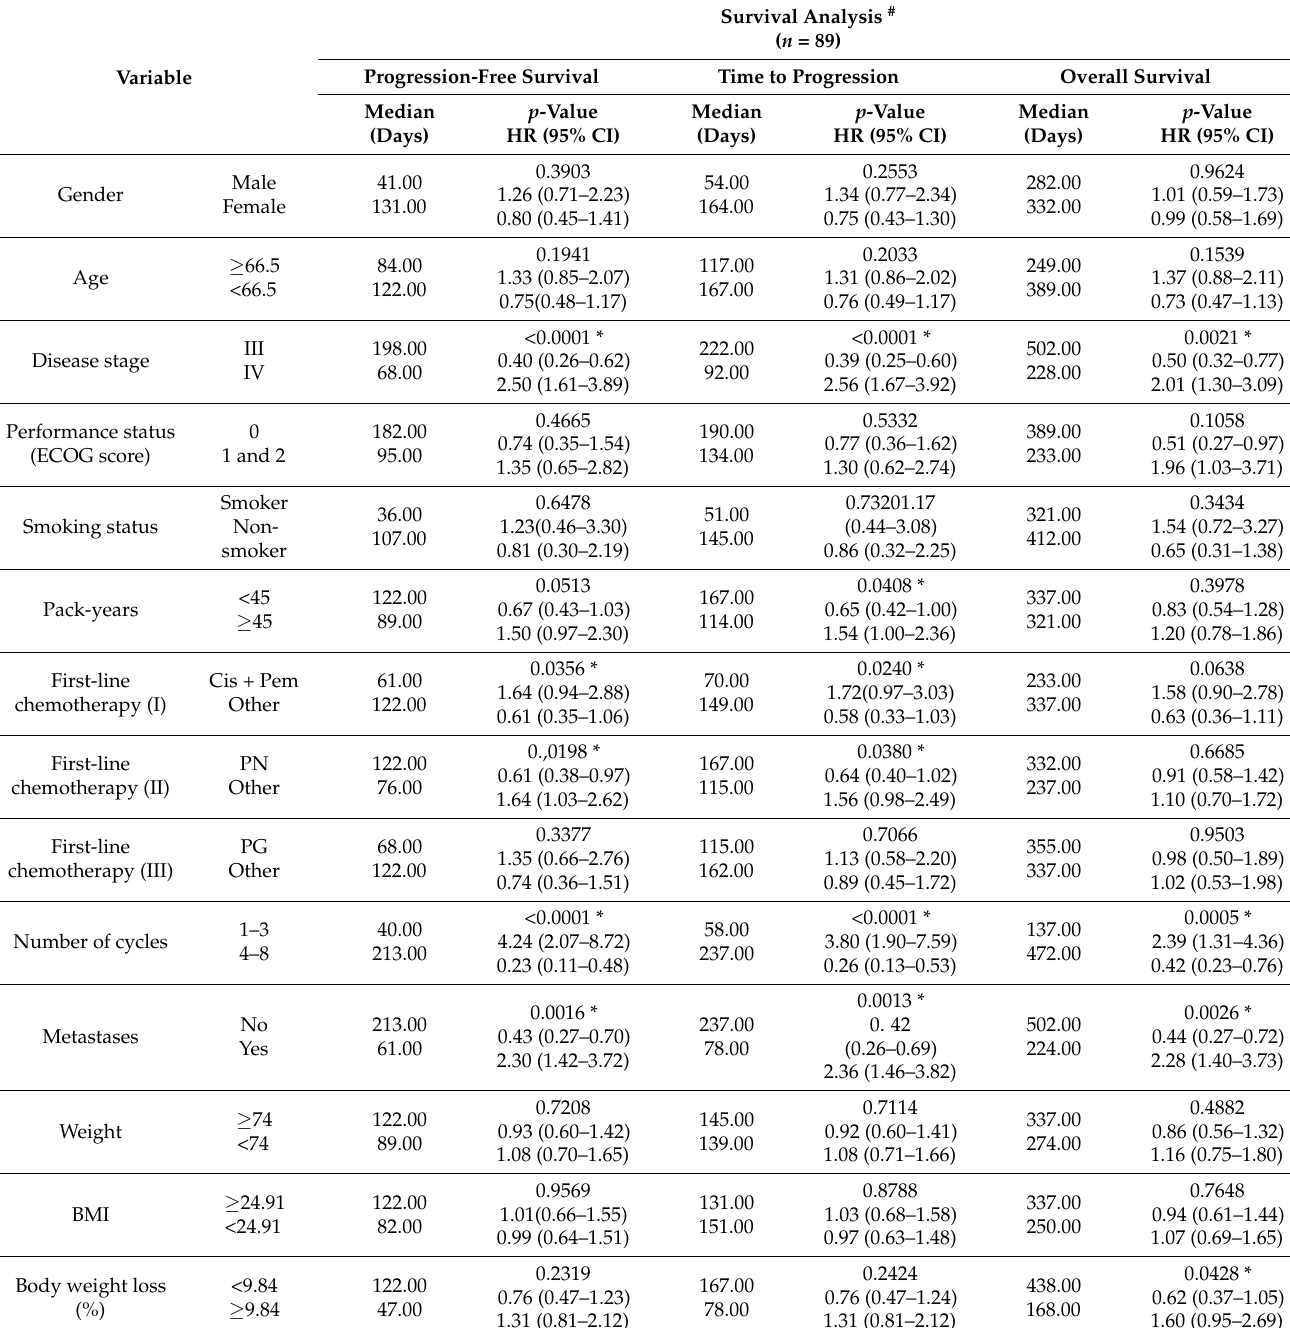
Table 5. Progression-free survival, time to progression, and overall survival according to demographic, clinical, and genetic